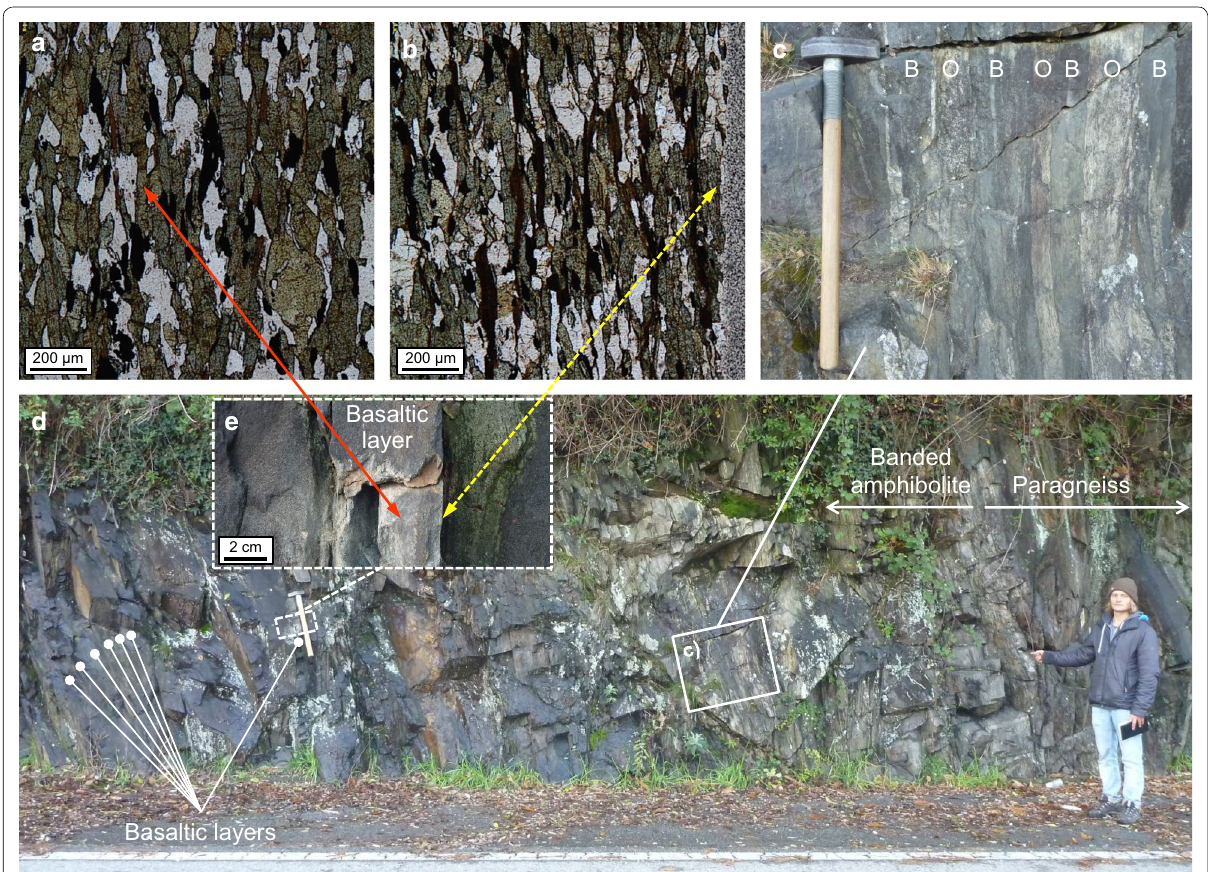
Fig. 2 Outcrop fotographs from the banded amphibolite formation at Molinetto, c. 1.5 km south of Cannobio in Italy (see Fig. 1c for location). a Micrograph of basaltic layer (located in d and e ) with b finer grained rim. c Intercalation of basaltic (B) and orthogneiss (O) layers. d The person to the right stands in the paragneisses right at the contact to the northern banded amphibolite body (Swiss coordinates: 2 ʹ 698 ʹ 003/1 ʹ 100 ʹ 519). See map of Fig.